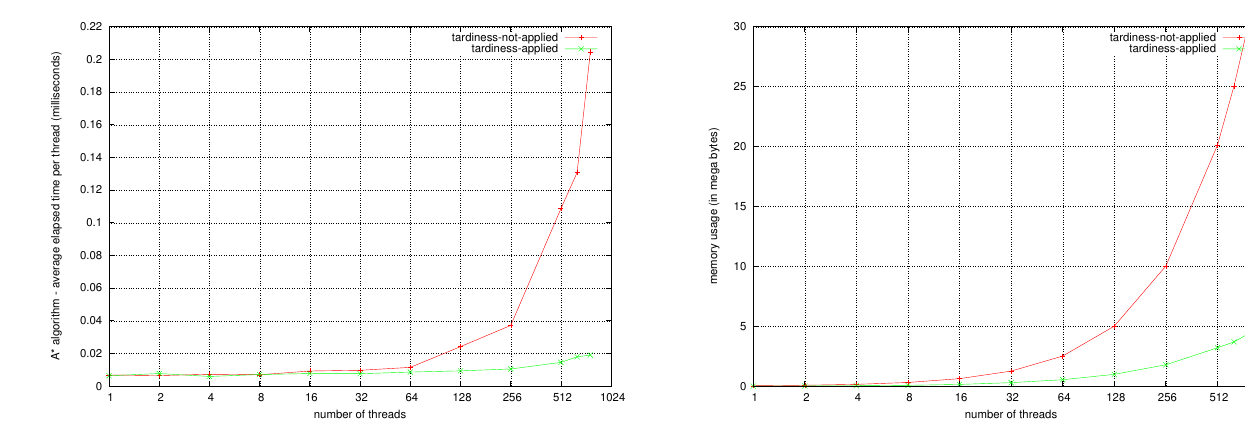
Fig. 7: A* pathfinding: average elapsed time per thread (milliseconds).